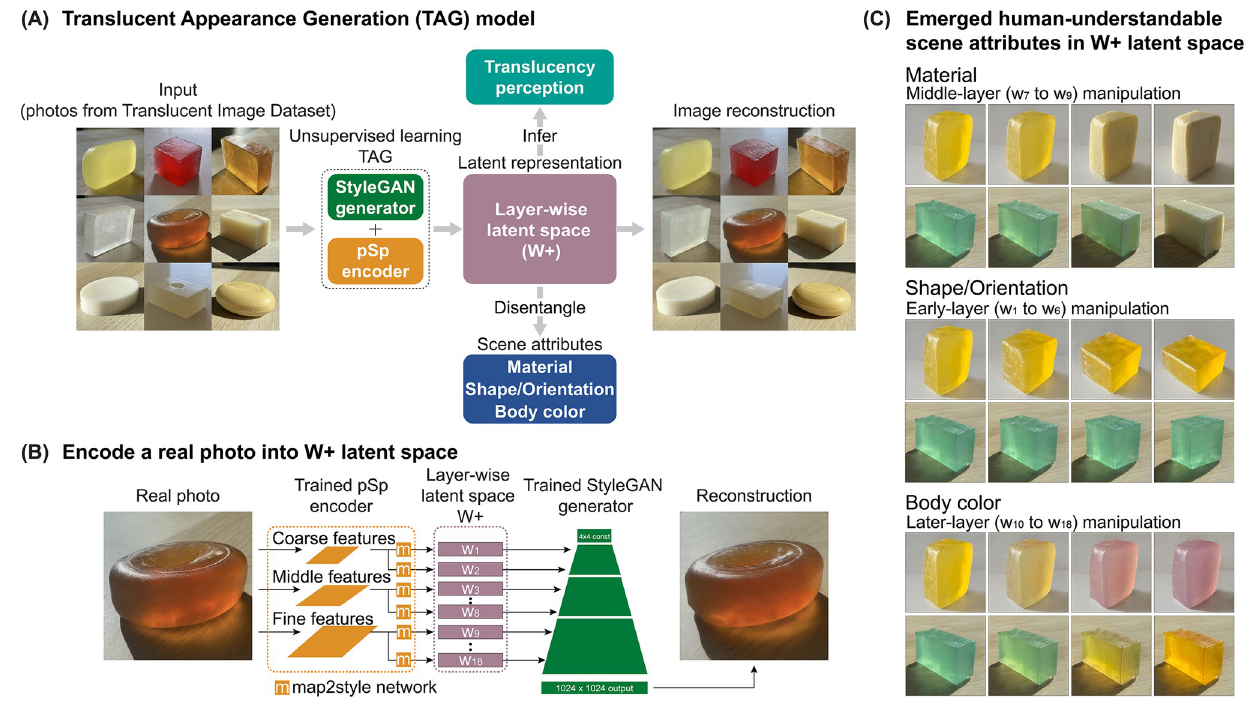
Fig 1. The Translucent Appearance Generation (TAG) model. (A) Given inputs of natural images, the TAG framework, which is based on the StyleGAN2-ADA generator and pSp encoder architectures, learns to synthesize perceptually convincing images of translucent objects. The model maps photos of translucent objects into the W + latent space. The W + can disentangle the effects of scene attributes (e.g., shape, material, and body color) and predict the human perception of translucency. (B) The detailed process of embedding a photo into StyleGAN’s W + latent space. This allows us to generate an image at a particular location in the latent space. (C) Emerged human-understandable scene attributes in the layer-wise latent space. Without supervision, the W + spontaneously disentangles three salient scene attributes: material, shape/orientation, and body color. In each row, an original generated image (left) is gradually manipulated by modifying its latent vectors at specific layers. Early-layer ( w 1 to w 6 ) manipulation of W + transforms the shape and orientation of the object. Middle-layer ( w 7 to w 9 ) manipulation modifies the material appearance. Later-layer ( w 10 to w 18 ) manipulation changes the body color (color of the diffuse component of the surface